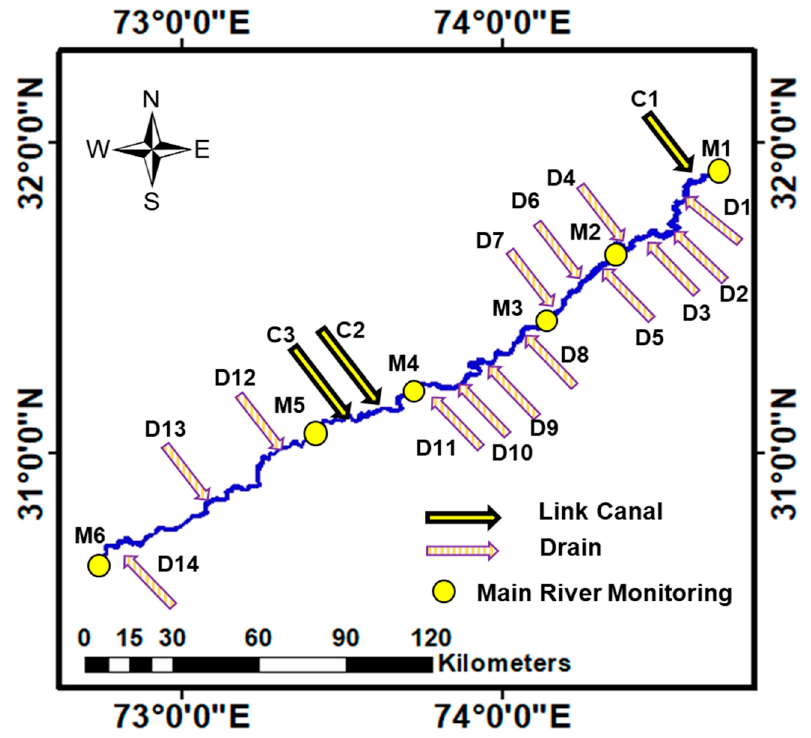
Figure 1. Location of study area and sampling points along the Ravi River in Punjab Province, Pakistan.